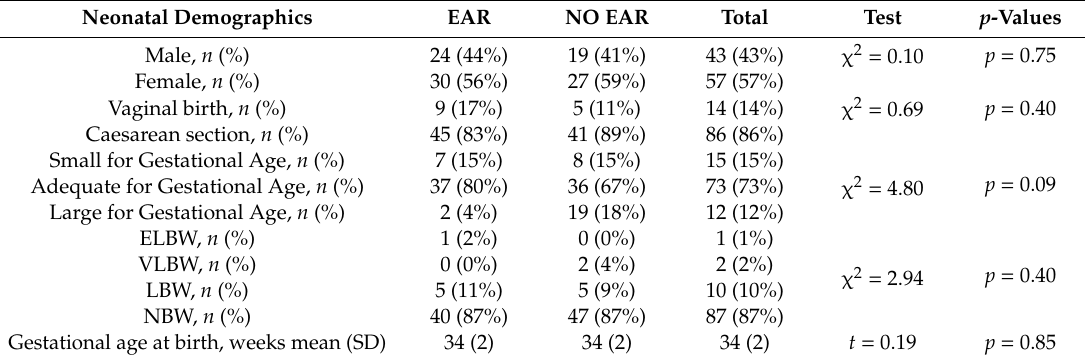
Table 1. Neonatal characteristics according to timing of adiposity rebound.